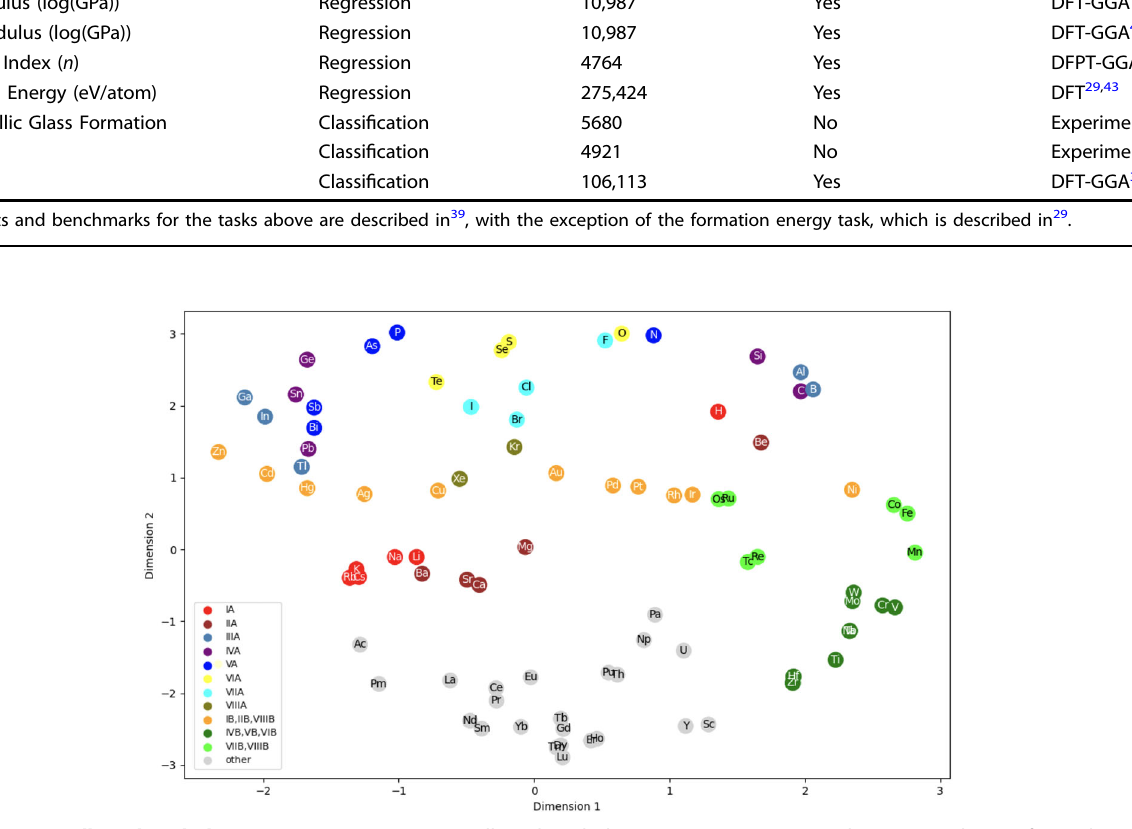
Fig. 2 Dimensionally-reduced SkipAtom vectors. Dimensionally-reduced SkipAtom atom vectors with an original size of 200 dimensions. The vectors were reduced to 2 dimensions using t-SNE. (See also Supplementary Figs. 1 and 2 for results of dimensionality reduction with